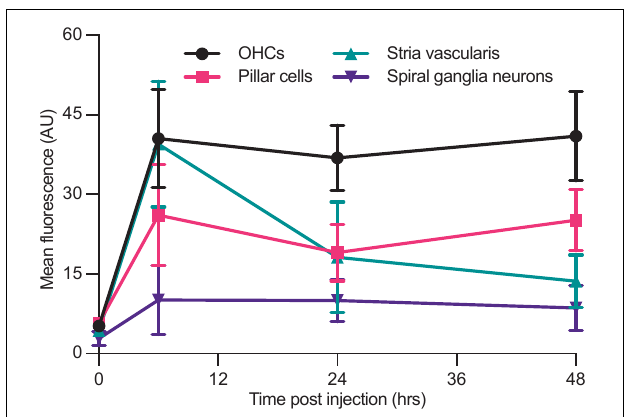
FIGURE 6 | Differential aminoglycoside uptake and retention within the cochlea. Cochlea from neonatal mice treated with G418-TR were fixed, cryostat sectioned, and signed in order to analyze the organ of Corti, stria vascularis, and spiral ganglia neurons. In order to compare relative G418-TR uptake between specific tissue types, fluorescence was quantified for outer hair cells (OHCs), pillar cells, stria vascularis, and spiral ganglia neurons. Note that while OHCs take up and retain G418-TR fluorescence, stria vascularis tissue has an early peak but then declines while SGNs show consistent low level uptake. PCs display an intermediate level of uptake with some retention. Error bars are standard deviations. Animal numbers [time (hours), n ] = (0,3), (6,4), (24,4), and